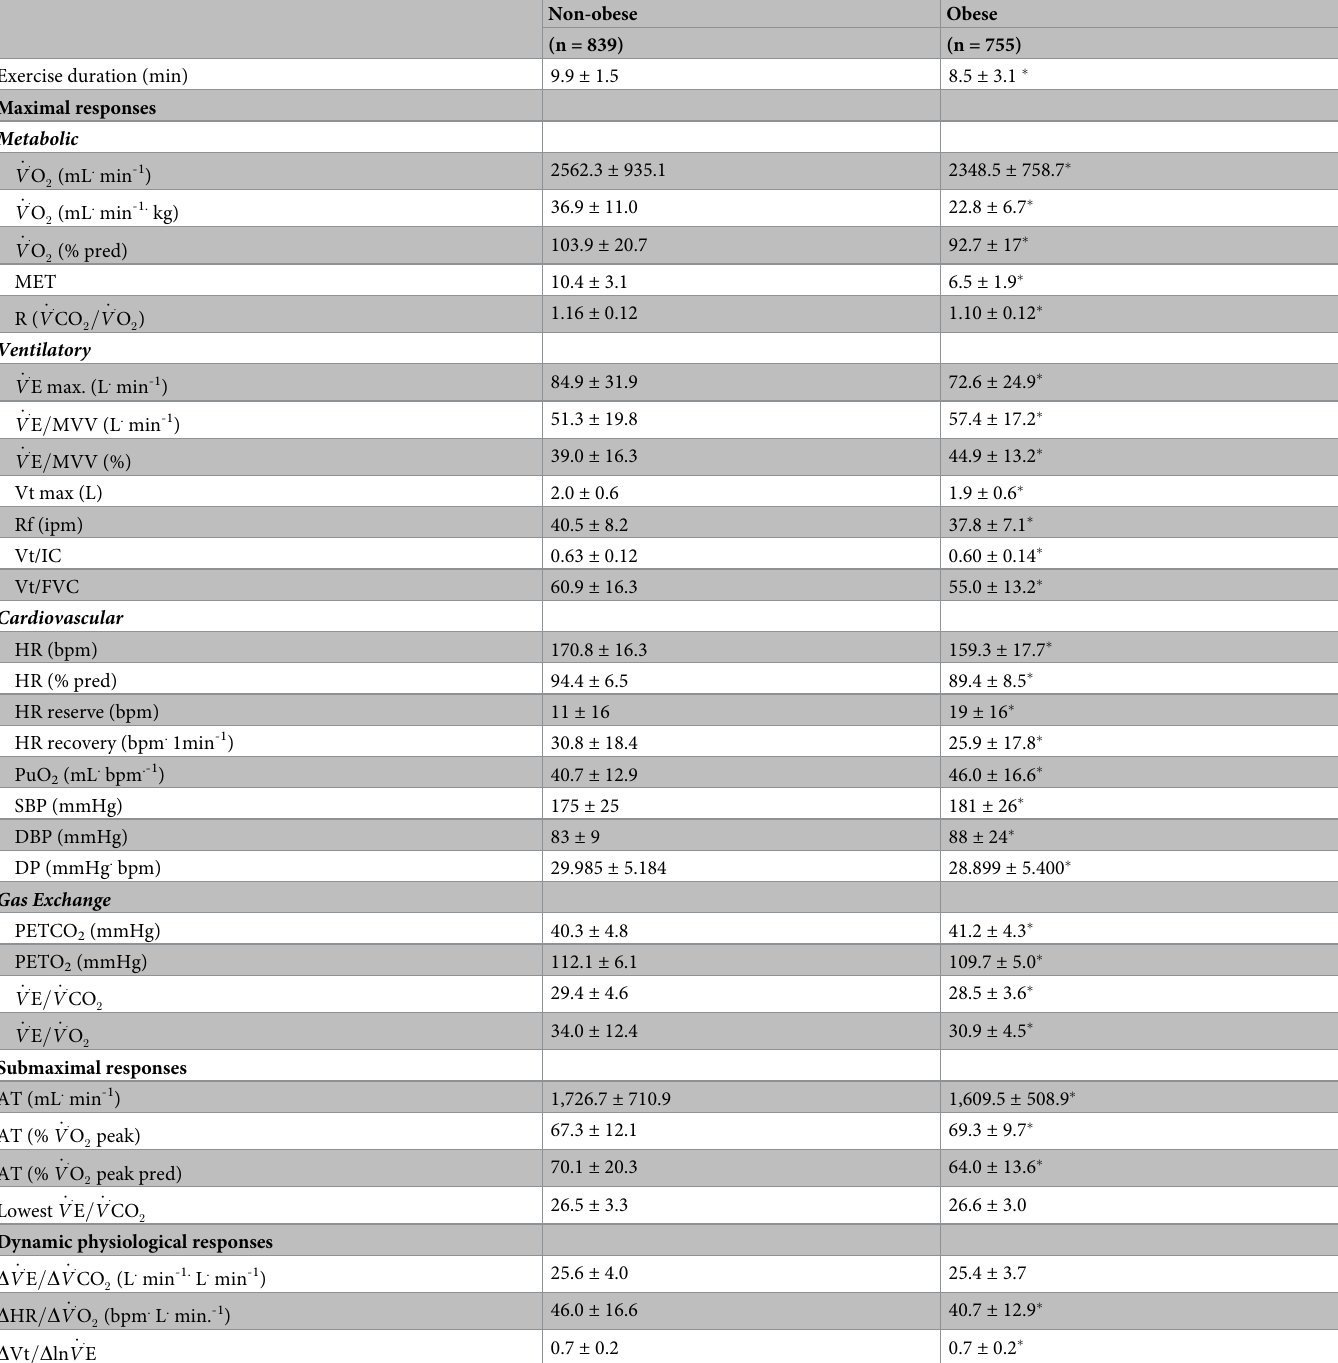
Table 2. Physiological responses to cardiopulmonary exercise testing according to non-obese and obese groups (n =